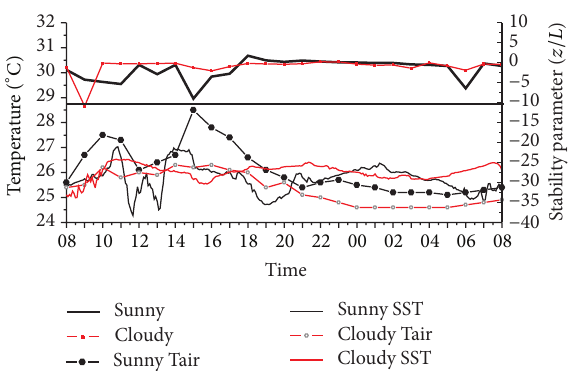
Figure 5: Air temperature and sea surface temperature on clear and cloudy days. The thin lines denote z/L on clear day (in black) and cloudy day (in